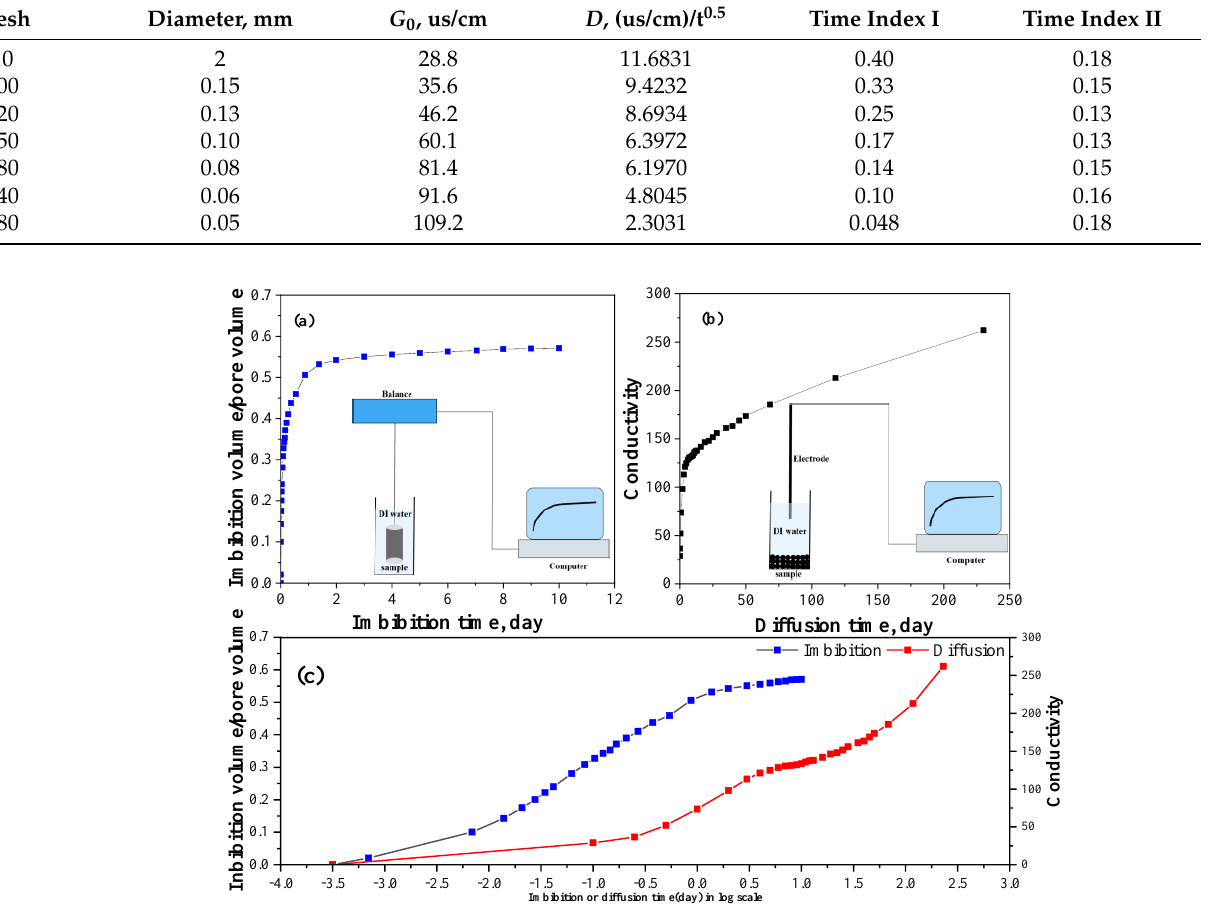
Figure 8. Ion diffusion curves of sandstone sample with different particle sizes: ( a ) conductivity over time 0.5 and ( b ) double logarithm of conductivity with time.